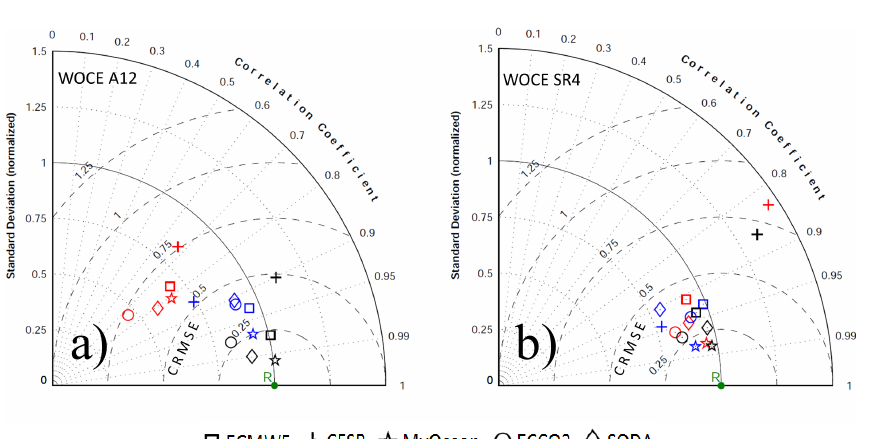
Figure 10. Taylor diagrams of sections WOCE A12 (a) and WOCE SR4 (b) . θ (blue), S (red), and γ n (black). ECMWF (square), CFSR (plus sign), MyOcean (pentagram), ECCO2 (circle), and SODA (diamond). Observed data serve as a reference (green R). 1125